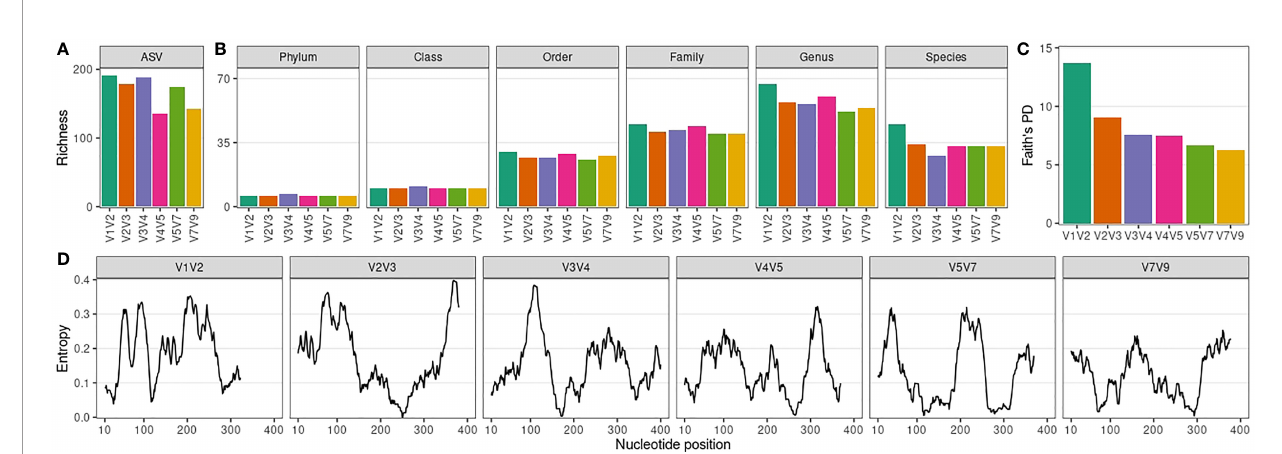
FIGURE 2 | Richness and phylogenetic diversity across 16S rRNA amplicon-speci fi c datasets. (A) Amplicon sequence variant (ASV) richness per amplicon-speci fi c dataset. (B) Taxonomic richness (phylum to species level) per amplicon-speci fi c dataset. (C) Faith ’ s Phylogenetic Diversity (PD) across amplicon-speci fi c datasets. (D) Sequence variability (entropy) along ASVs nucleotide positions (20-nucleotides rolling average) for each amplicon-speci fi c dataset. Only nucleotide positions up to the median ASV size per amplicon-speci fi c dataset are